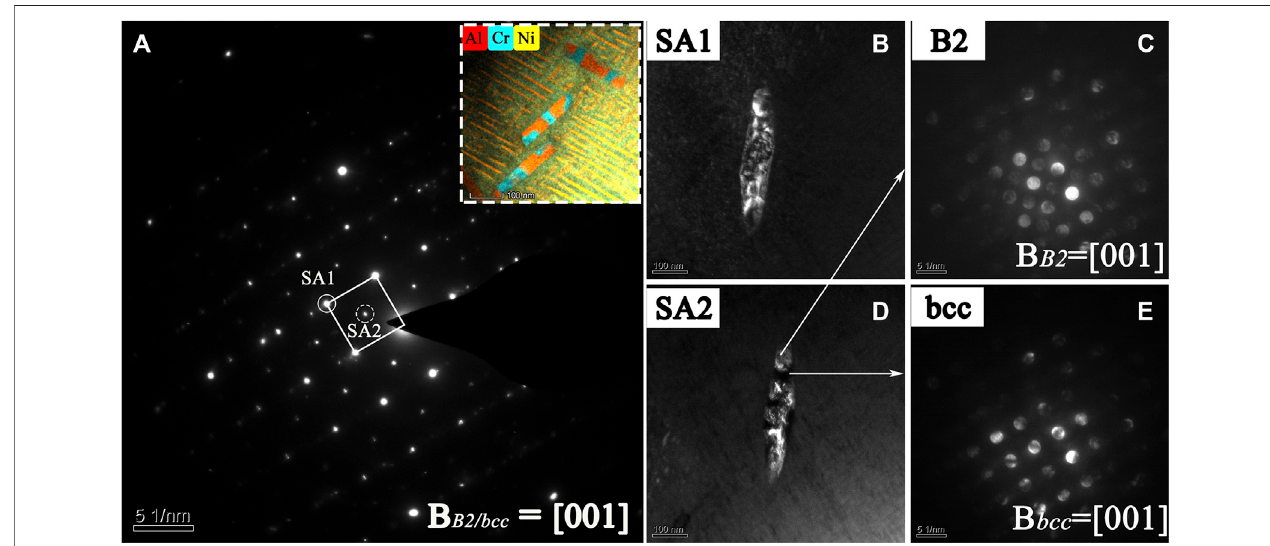
FIGURE 5 | (A) the SADP image from the [001] bcc zone axis of the B2/bcc region with the image ofHAADF-EDS (B,D) dark fi eld images from the [001] B2/bcc zone axis, and (C,E) the corresponding electron diffraction patterns of the CRSA-140 Al 0.5 CoCrFeNi alloy (Yang et al., 2020). (Reprinted from Journal of Materials Science & Technology, Vol 72, Yang et al., Nanophase precipitation and strengthening in a dual-phase Al0.5CoCrFeNi high-entropy alloy, Pages No.6, Copyright (2021), with permission from Elsevier).